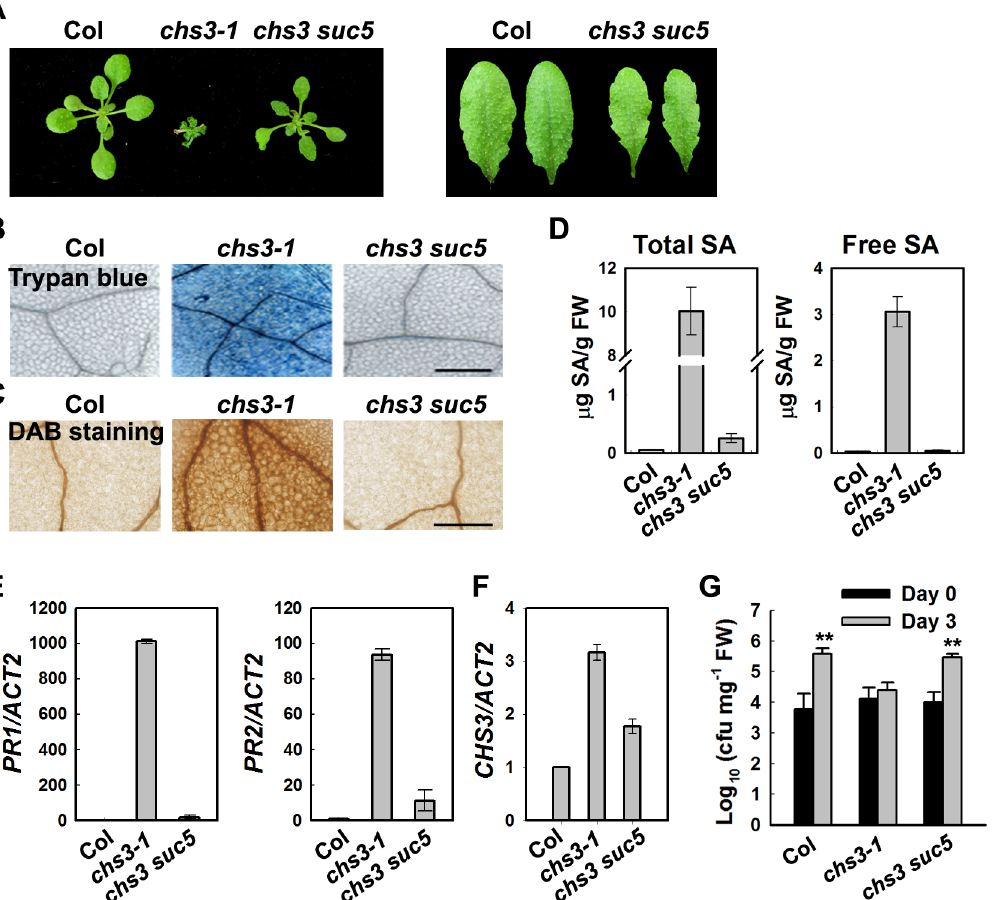
Fig 1. Identification of a suppressor of chs3-1 , suc5 . (A) Morphology of wild-type (Col), chs3-1 and chs3 suc5 plants grown at 16°C. The photographs show 4-week-old plants grown in soil (left panel). The rosette leaves of chs3 suc5 have increased leaf serration compared with Col (right panel). (B, C) Trypan blue and DAB staining of leaves from 3-week-old wild type, chs3-1 and chs3 suc5 plants grown at 16°C. Bars: 200 μ m. (D) Levels of total and free SA in 4-week-old, wild-type, chs3-1 and chs3 suc5 plants grown at 16°C. (E, F) Expression of PR1 , PR2 (E) and CHS3 (F) genes in 3-week-old wild-type, chs3-1 and chs3 suc5 plants grown at 16°C. The values were normalized to the expression of ACTIN2 . The error bars represent the SD of three replicates. Similar results were obtained in three independent experiments. (G) Growth of P . s . t . DC3000 on wild-type, chs3-1 , and chs3 suc5 plants. Three-week-old plants were dipped with P . s . t . DC3000 (OD 600 = 0.05). Bacterial growth was monitored as described in the Materials and Methods. The error bars represent the SD of three replicates, and the asterisks indicate significant differences compared with wild-type Col ( ** P < 0.01, t